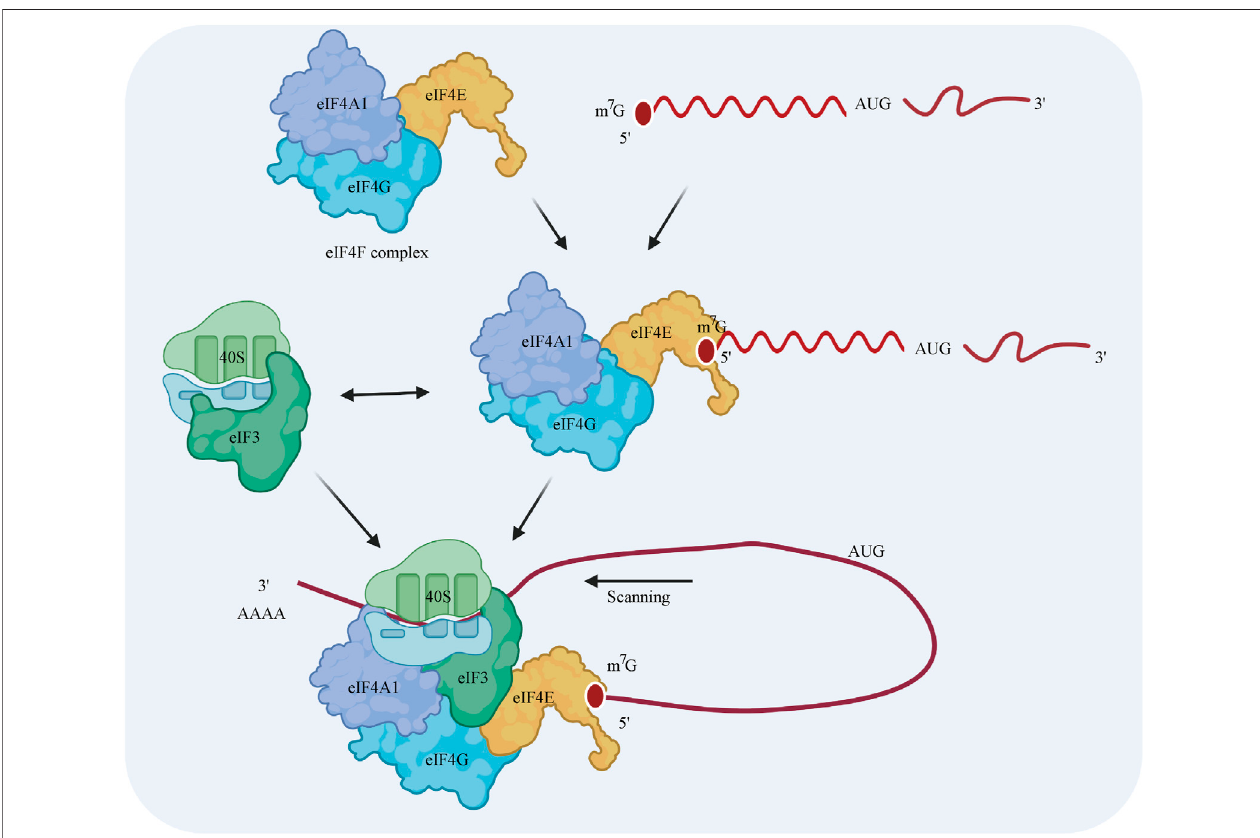
FIGURE 2 | Model of the regulatory mechanism by which eIF4A1 initiates cap-dependent translation. The eIF4F cap-binding complex is composed of the eIF4A1 translation initiation factor, the eIF4G scaffolding protein, and the eIF4E m 7 G cap-binding protein. The 40S ribosomal subunit is recruited by interacting with eIF4F and eIF3 prior to the binding of eIF4F to the 5 ′ cap of the mRNA. This 43S preinitiation complex scans the 5 ′ -UTR for the AUG initiation codon. During this process, eIF4A1 unwinds the stable secondary structures in the 5 ′ -UTR of the mRNA.